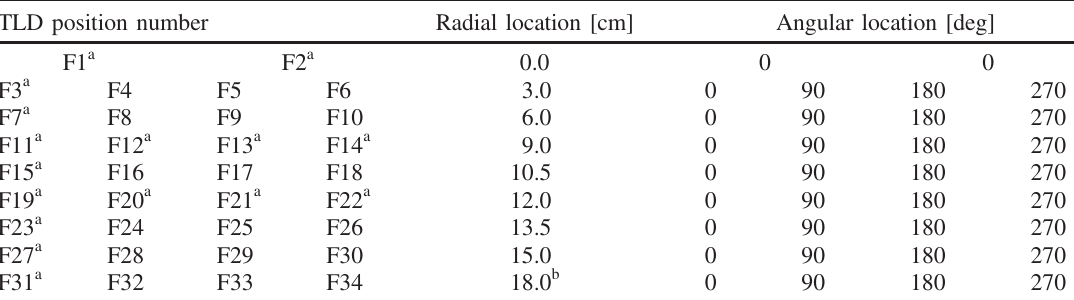
TABLE I. Locations of the near-field TLDs in this experimental campaign. TLD position number Radial location [cm]